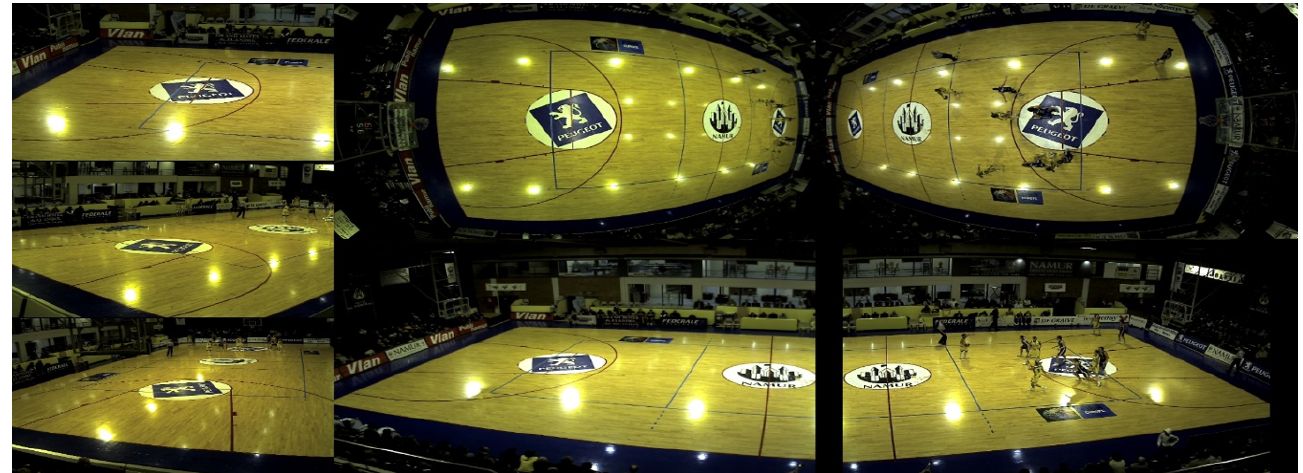
Figure 13. Instances from the APIDIS dataset [280].